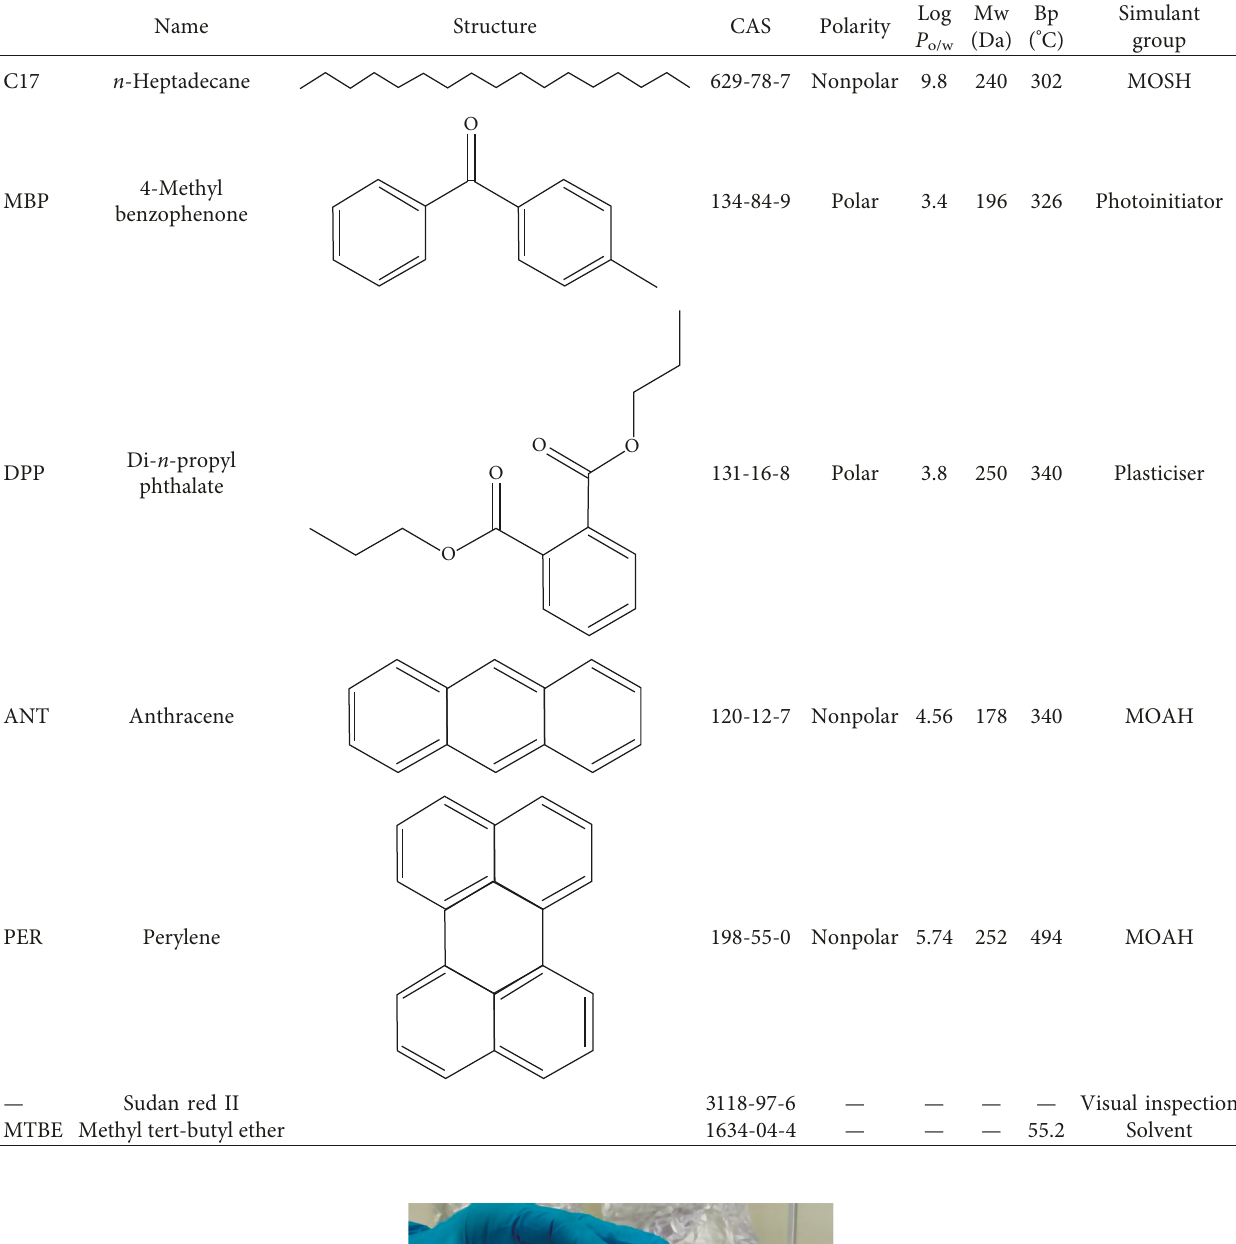
Table 2: Components used in the spike solution and their physical and chemical properties. For each substance, the structure, CAS Registry Number, polarity, partition coefficient for octanol/water (log P o/w ), molar weight (Mw), boiling point (Bp), and simulant group are given.